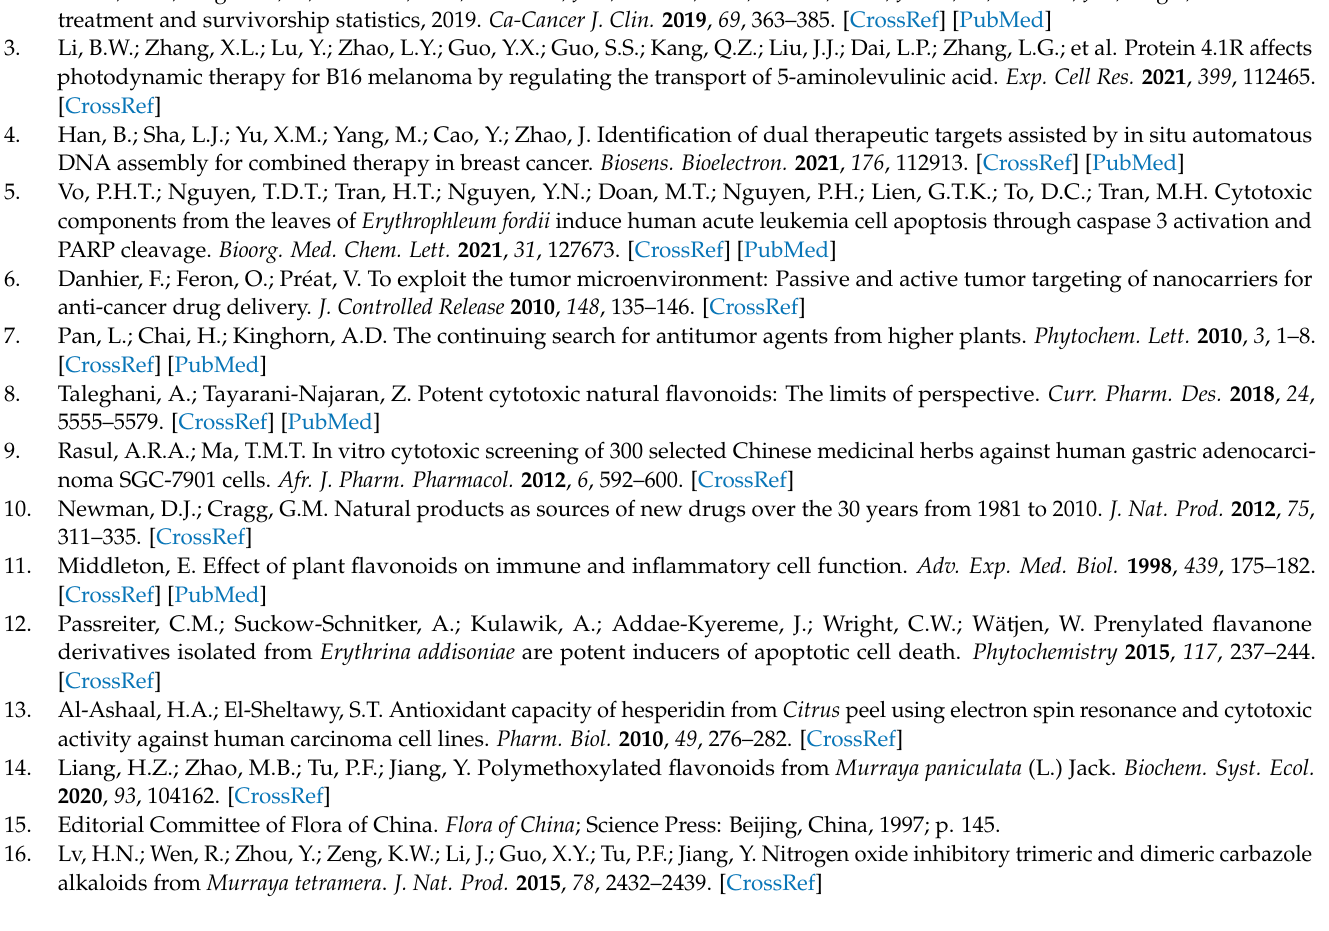
Supplementary Materials: The following are available online, Figure S1: 1 H-NMR spectrum of com- 6 , Figure S4: HR-ESI-MS spectrum of compound 6 , Table S1: 1 H-NMR data of the twelve known flavonoids, Table S2: 13 C-NMR data of the twelve known